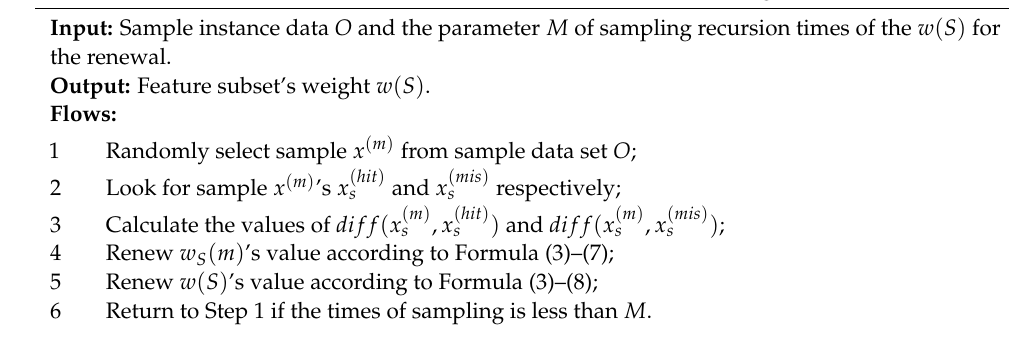
Algorithm 1: Evaluate F S ( O , S , M ) —FSIRW feature subset evaluation algorithm.